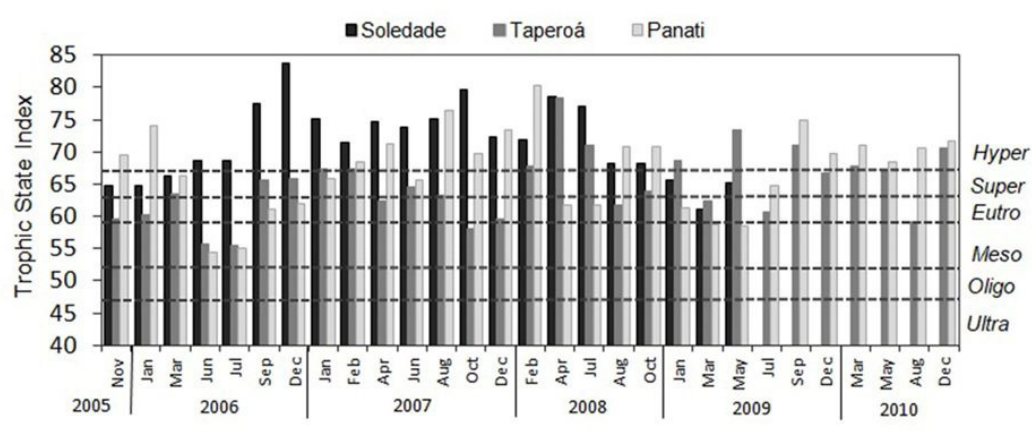
Figure 3. Trophic State Index (TSI) of the Soledade and Taperoá reservoirs and Panati lagoon from November 2005 to December 2010. Legend: Ultra (ultraoligotrophic), Oligo (oligotrophic), Meso (mesotrophic), Eutro (eutrophic), Super (supereutrophic), Hyper (hypertrophic). Missing data (total phosphorus) in the Soledade reservoir from Jul/2009 to